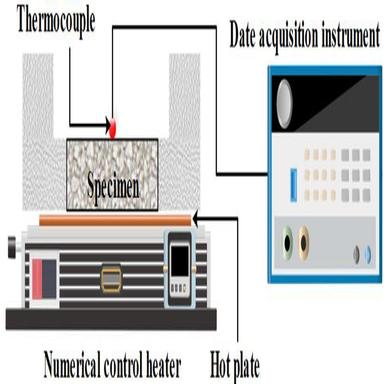
The sketch of heat storage and release characteristic testing system.